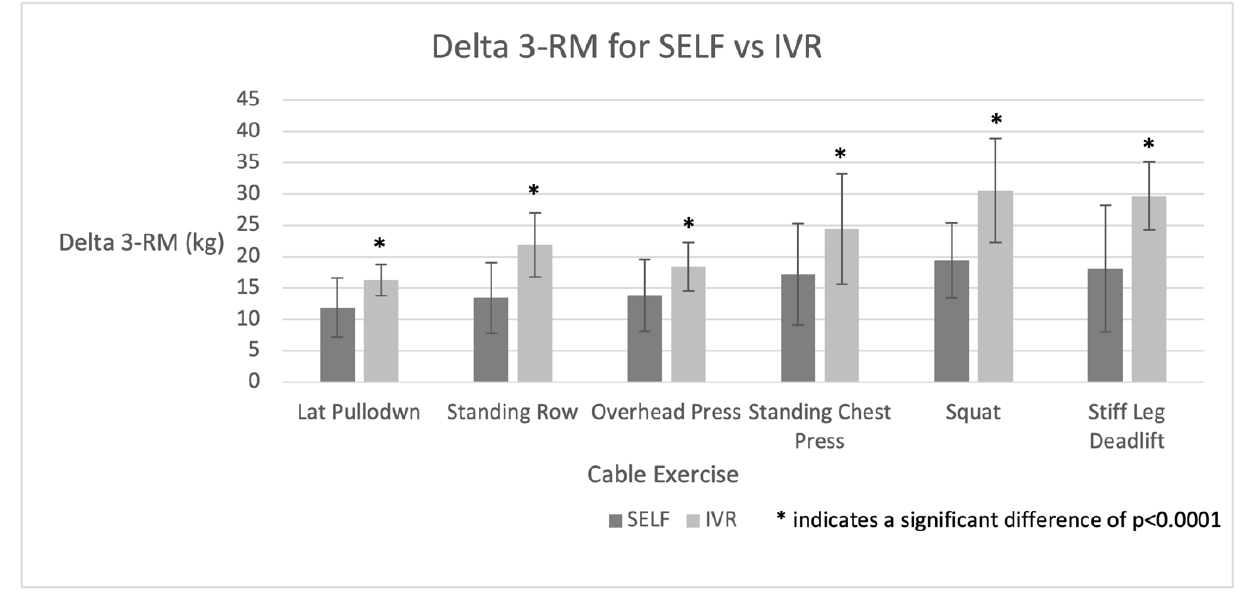
Figure 4. Change in Baseline to 12-week Post-intervention 3-RM for Various Cable Exercises for IVR and SELF Groups. and SELF